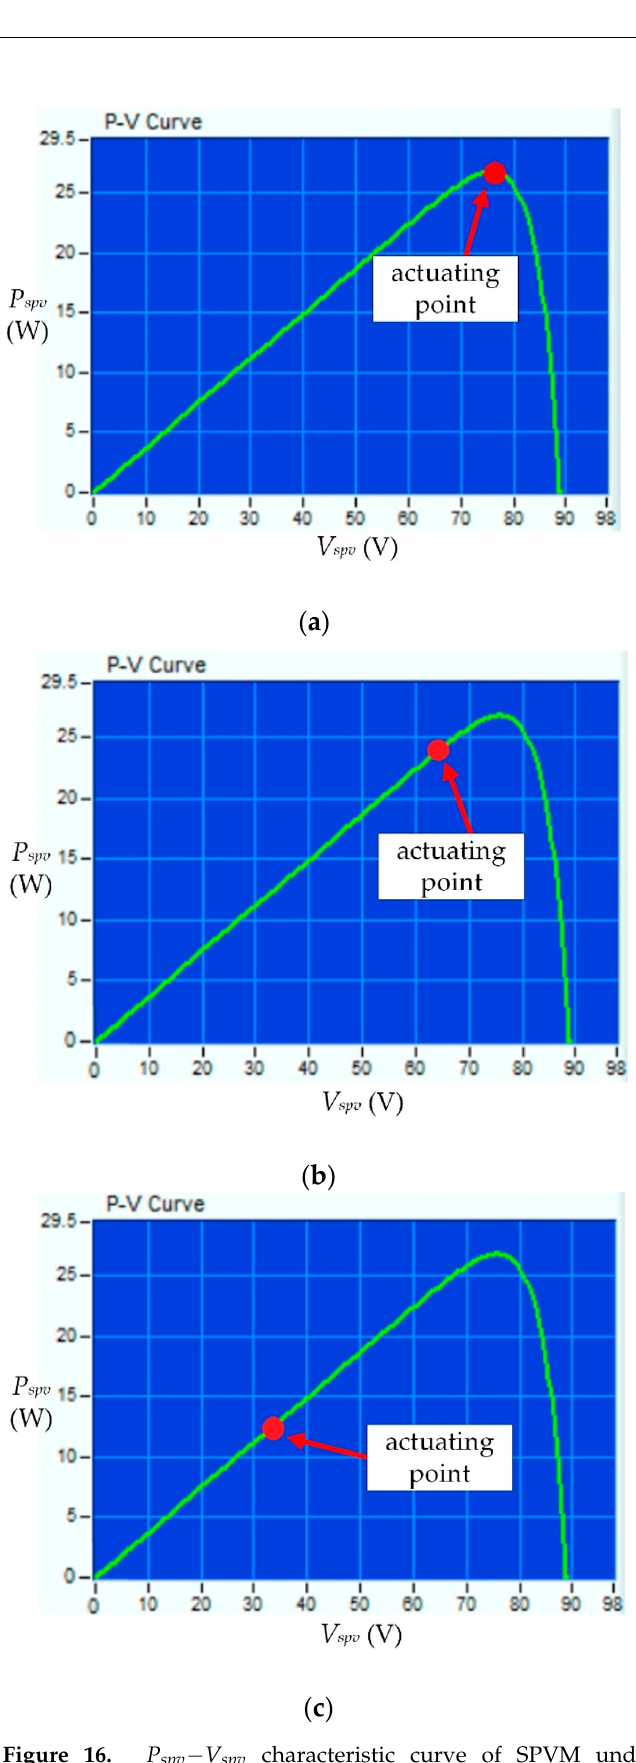
Figure 16. P spv − V spv characteristic curve of SPVM under UIC at IL = 65 W/m 2 and temperature = 25 °C by using the control strategy ( a ) SLOPDM, ( b ) SAH, and ( c ) P&O algorithms.